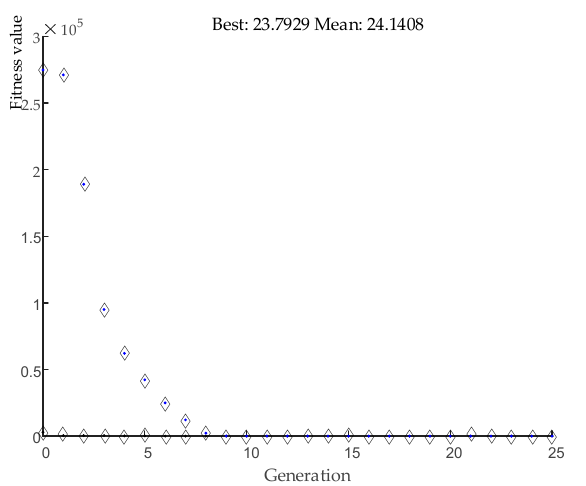
Figure 12. Optimal Solution Curve of Each Generation.